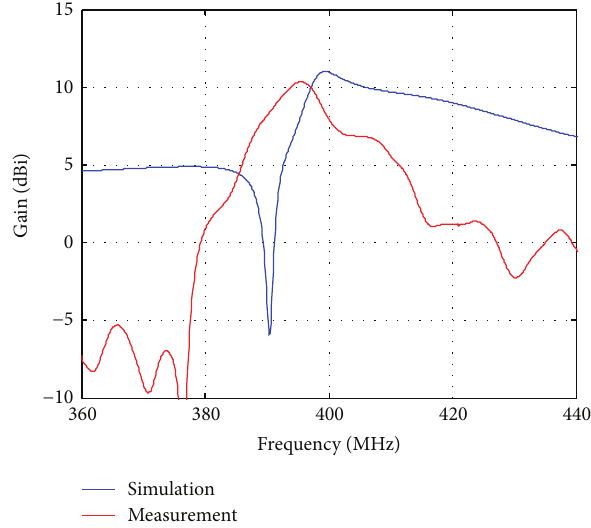
Figure 11: Simulated and measured antenna